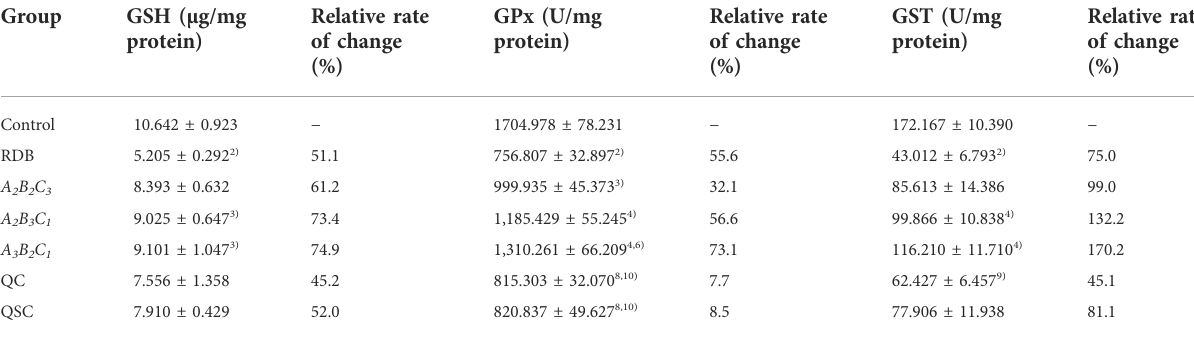
TABLE 8 Processing with ASR remarkably enhanced levels of glutathione antioxidant enzymess in the liver of mice caused by RDB. Group